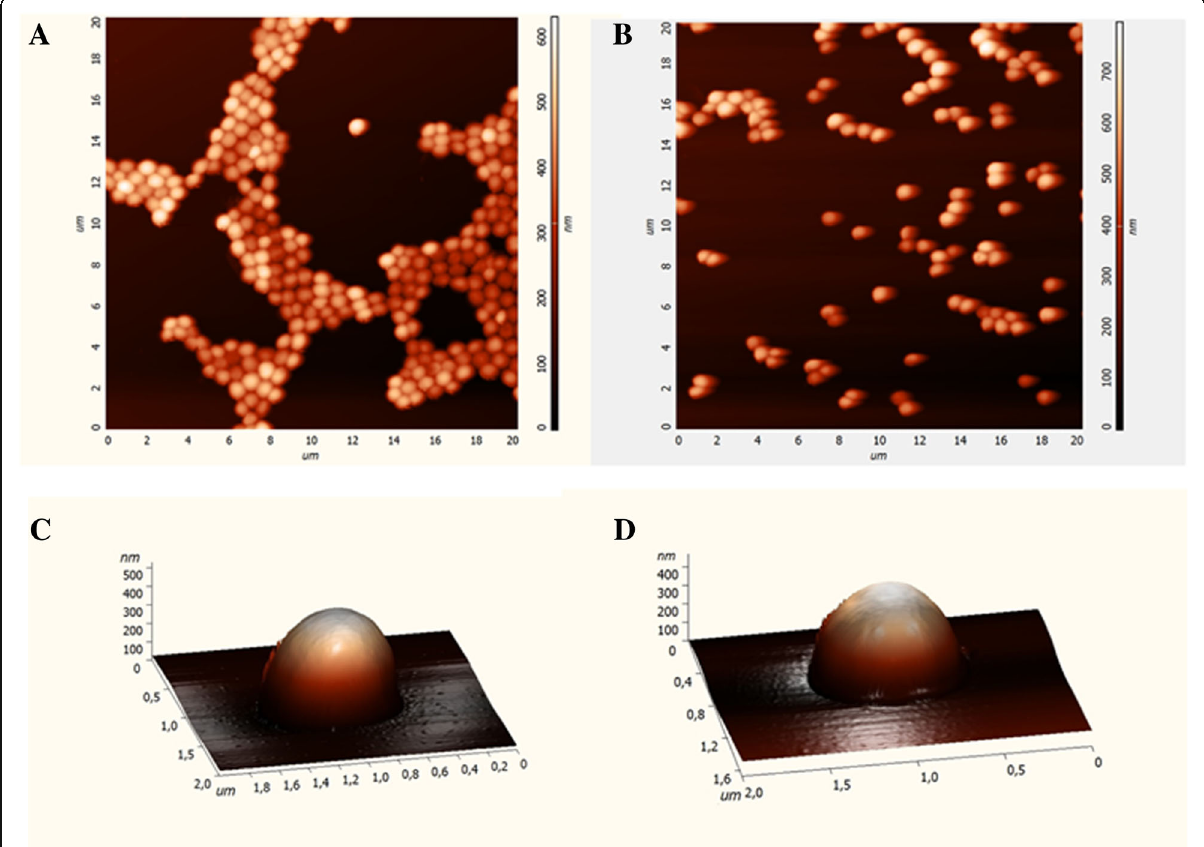
Fig. 5 Atomic force microscopy of Staphylococcus aureus ATCC 29213 cells exposed ( b and d ) and not exposed ( a and c ) to fraction 11FO d